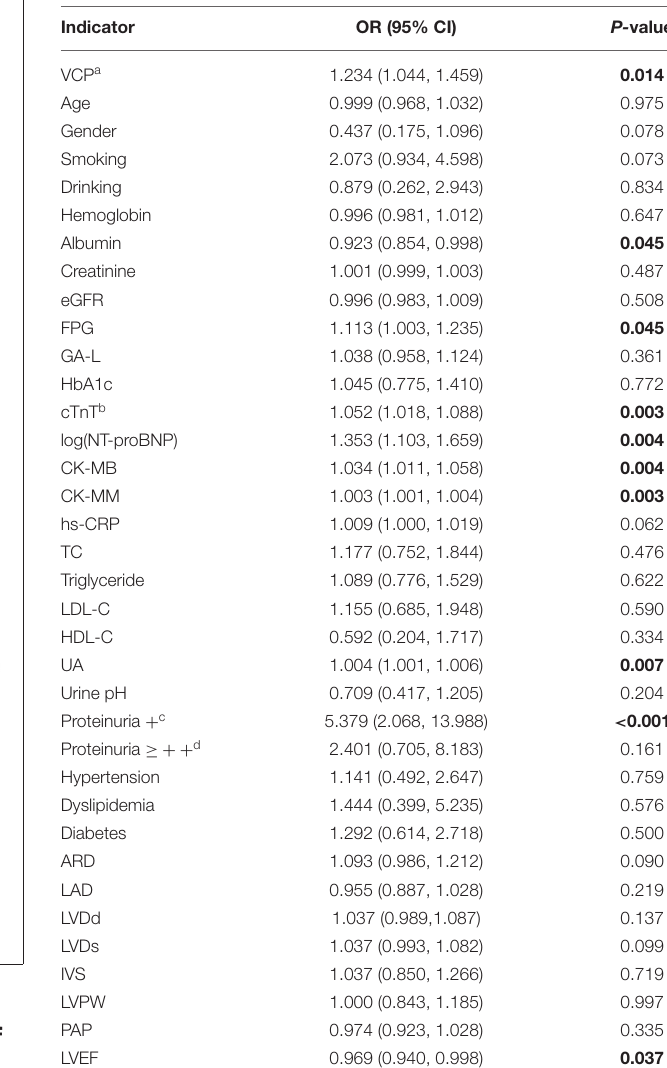
a VCP increases by 100 units. b cTnT increases by 0.003 units. c Compared with nonproteinuria group. d Compared with nonproteinuria group. Bold value indicates the statistical